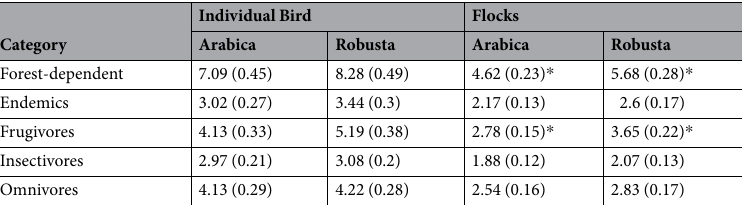
Table 3. Individual bird and flock densities for different avian groups in arabica or robusta . Densities are reported in birds/ha or flocks/ha (standard error in parentheses). The asterisk ( * ) denotes densities that were significantly different across the coffee